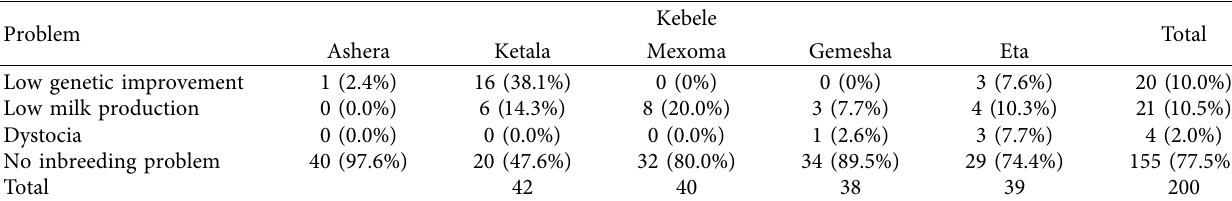
Table 6: Problem of inbreeding in the survey site.